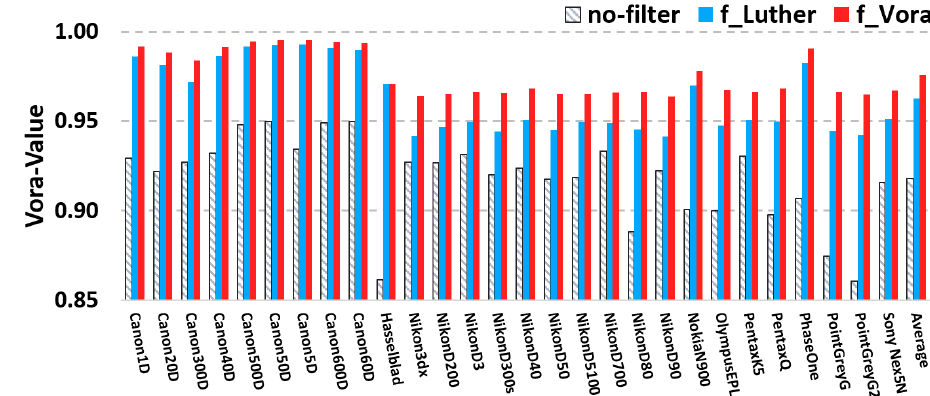
Figure 5. Results of Vora-Values for a group of 28 cameras: native sensitivities with no filter applied (neutral), the Luther filters optimized from the CMFs (blue) and the orthonormal-modified sensitivities (red). The overall averaged Vora-Values of the camera group are given in the last